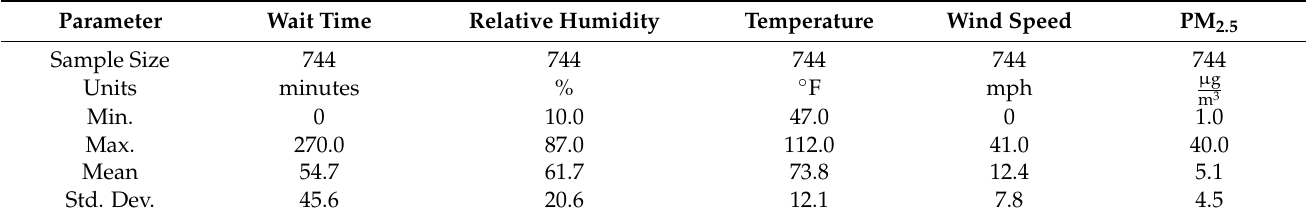
Table 2. Descriptive Statistics of Data Collected.